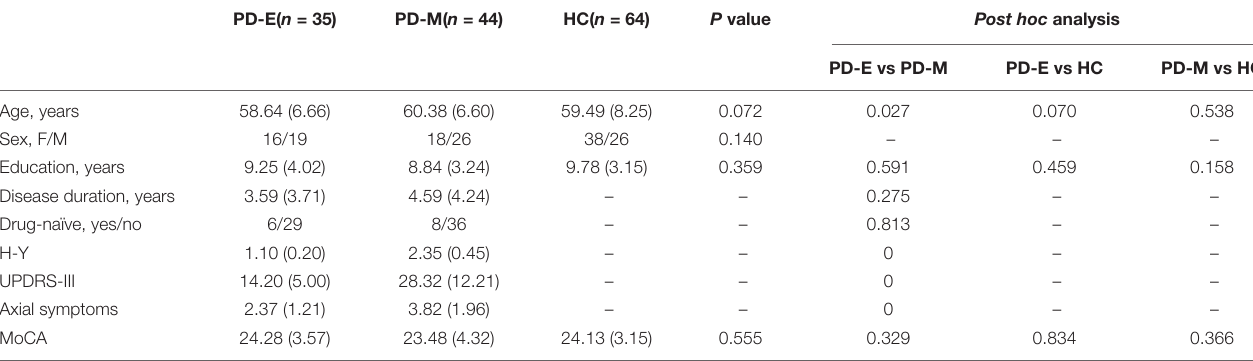
TABLE 1 | Demographic and clinical information for the